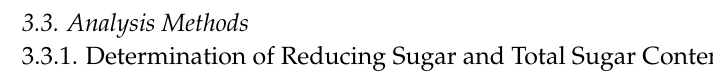
Figure 4. Preparation process of refining sesame oil.